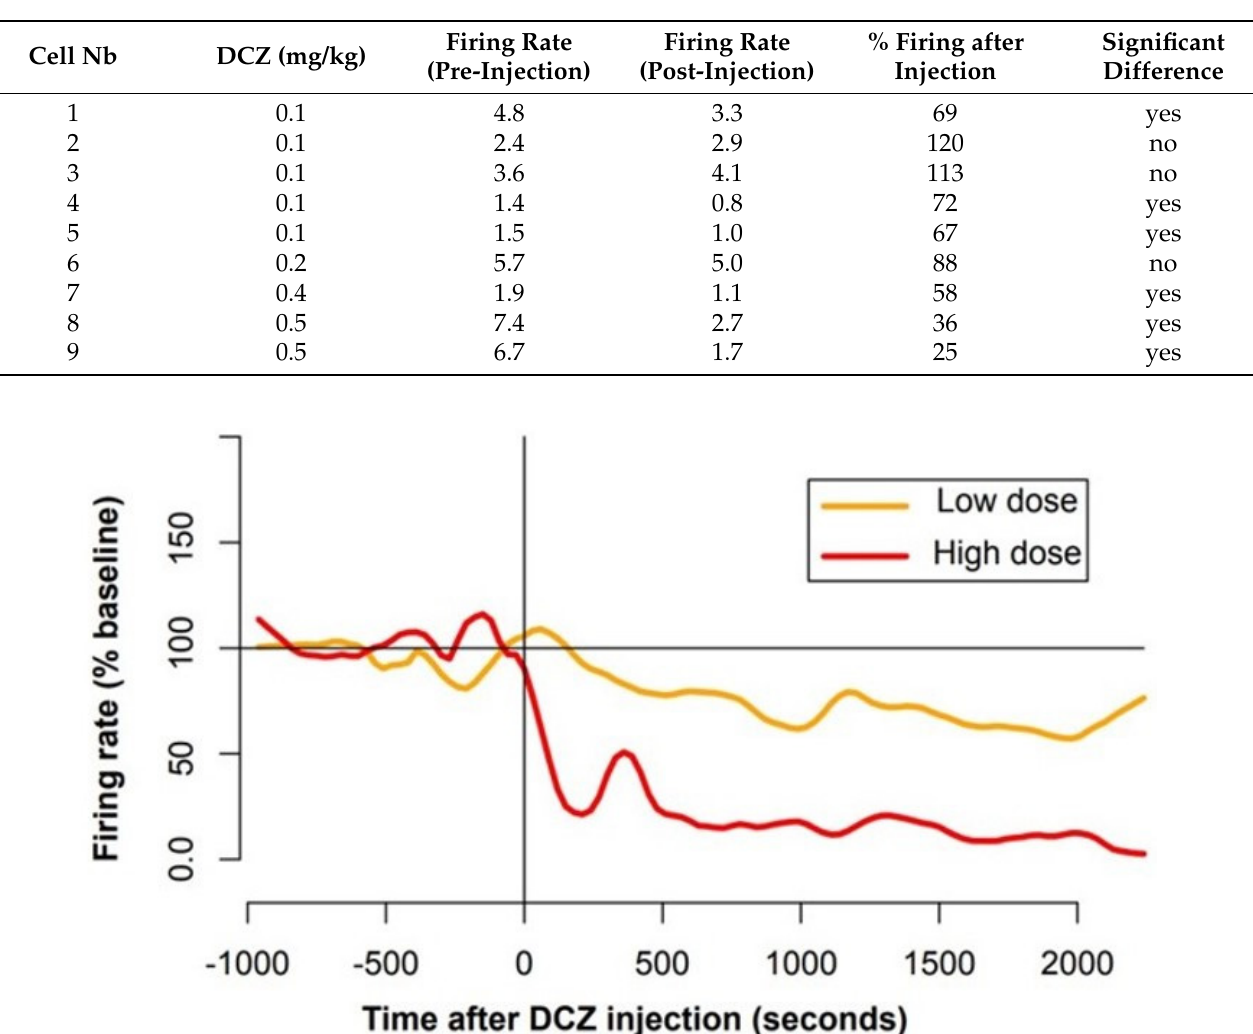
Figure 6. Influence of DREADD activation on LC activity. Averaged firing rate of LC units was computed separately for neurons tested with high doses of DCZ (in red, 0.4 mg/kg, n = 1 and 0.5 mg/kg, n = 2) and for neurons tested with a lower dose (in orange, 0.1 mg/kg, n = 5 and 0.2 mg/kg, n = 1). Individual firing rates were normalized using a 5 min baseline window, and data were smoothed for clarity. The injection (t = 0, vertical line) induced a rapid decrease in activity, which was more pronounced for higher doses of DCZ. The activity of LC neurons decreased rapidly, and after 15 min, they remained lower than baseline for at least 1 h. Table 1. Influence of DCZ injection on individual LC units.